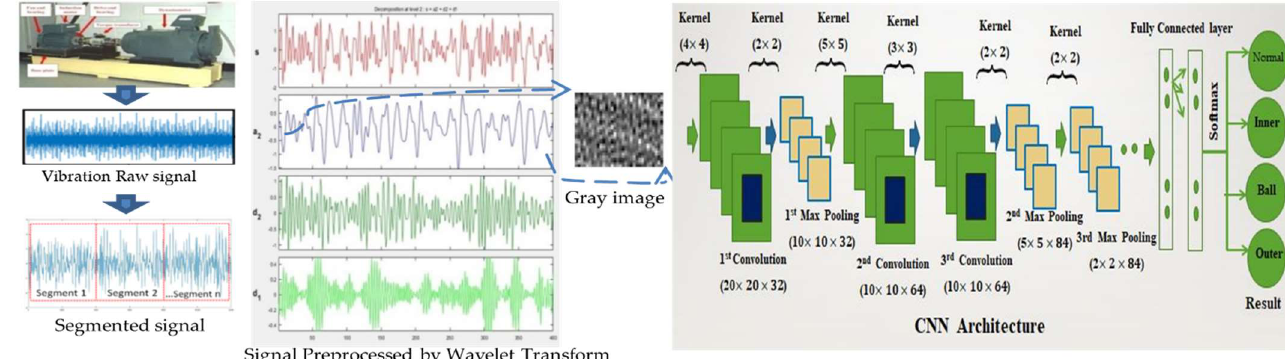
Figure 1. Proposed System Architecture.